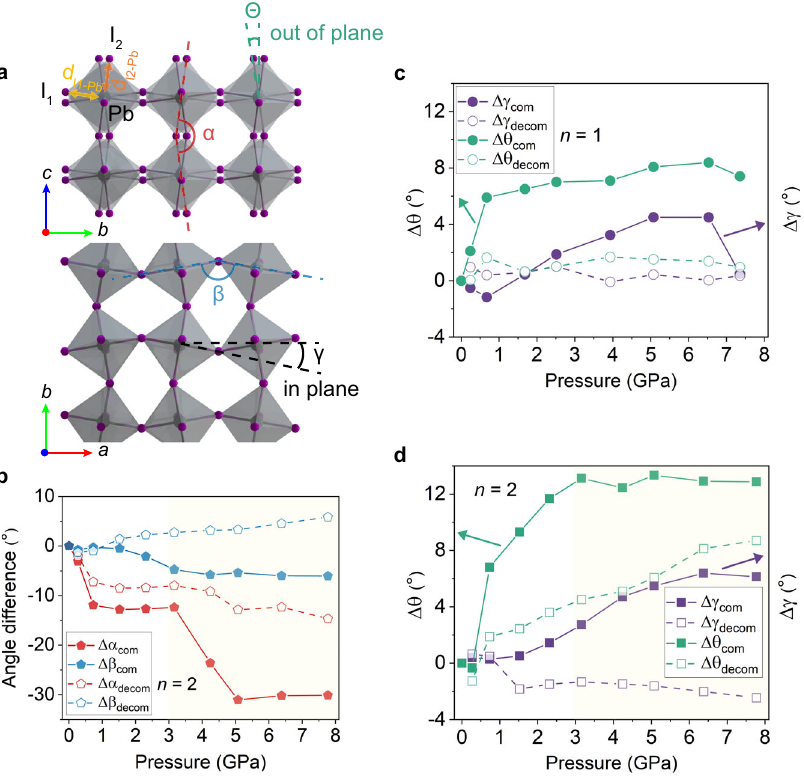
b Evolutionof Δα and Δβ in n =2undercompressionanddecompression.Evolution of the Δ ɵ and Δγ in n =1 RPP ( c ) and n =2 RPP d under compression and decom- pression. The yellow-shaded area in b , d represents the irreversible deformation region. Source data are provided as a Source Data fi